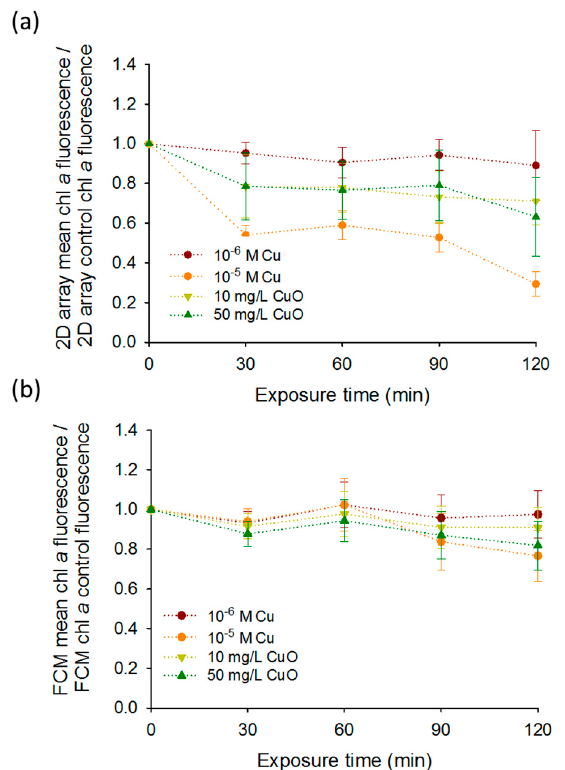
Figure 4. CuO-NPs and Cu effects on C. reinhardtii fluoresecence obtained by ( a ) 2D-array and ( b ) FCM. Time course of ( a ) the mean fluorescence normalized by the control fluorescence obtained by 2D-array ( b ) the mean fluorescence normalized by the control fluorescence obtained by FCM of cells exposed to increasing Cu and CuO-NPs concentrations.